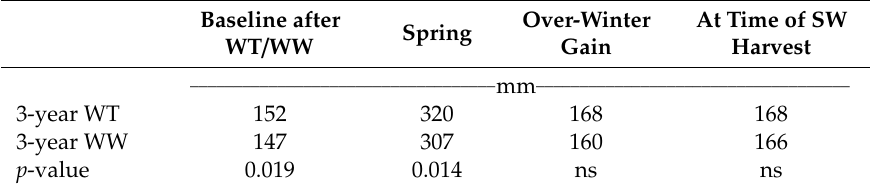
Table 2. Soil water content: (i) in August at time of harvest of winter triticale (WT) and winter wheat (WW), (ii) in the standing and undisturbed stubble of WT and WW in early spring, and (iii) at the time of spring wheat (SW) harvest in August. Data are averaged over eight years (2012–2019). ns = not significant.